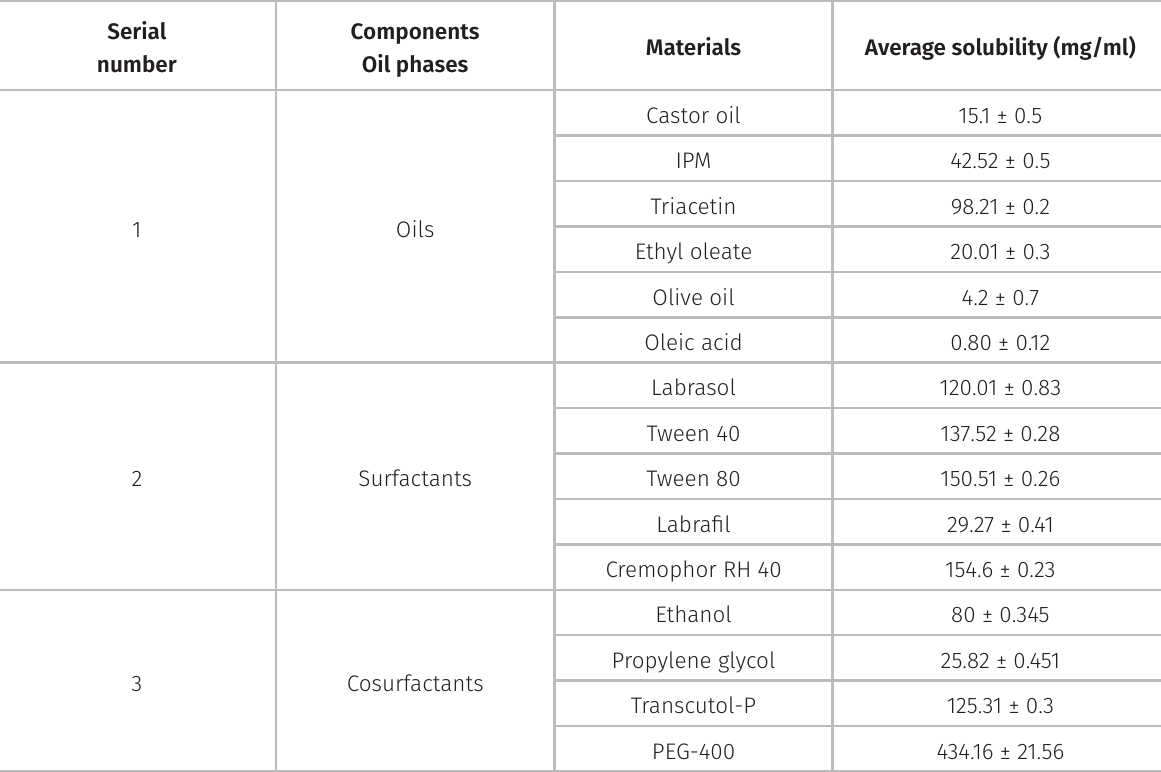
Table I. Solubility of Celecoxib in oils, surfactants and co-surfacatants, values presented are mean +SD